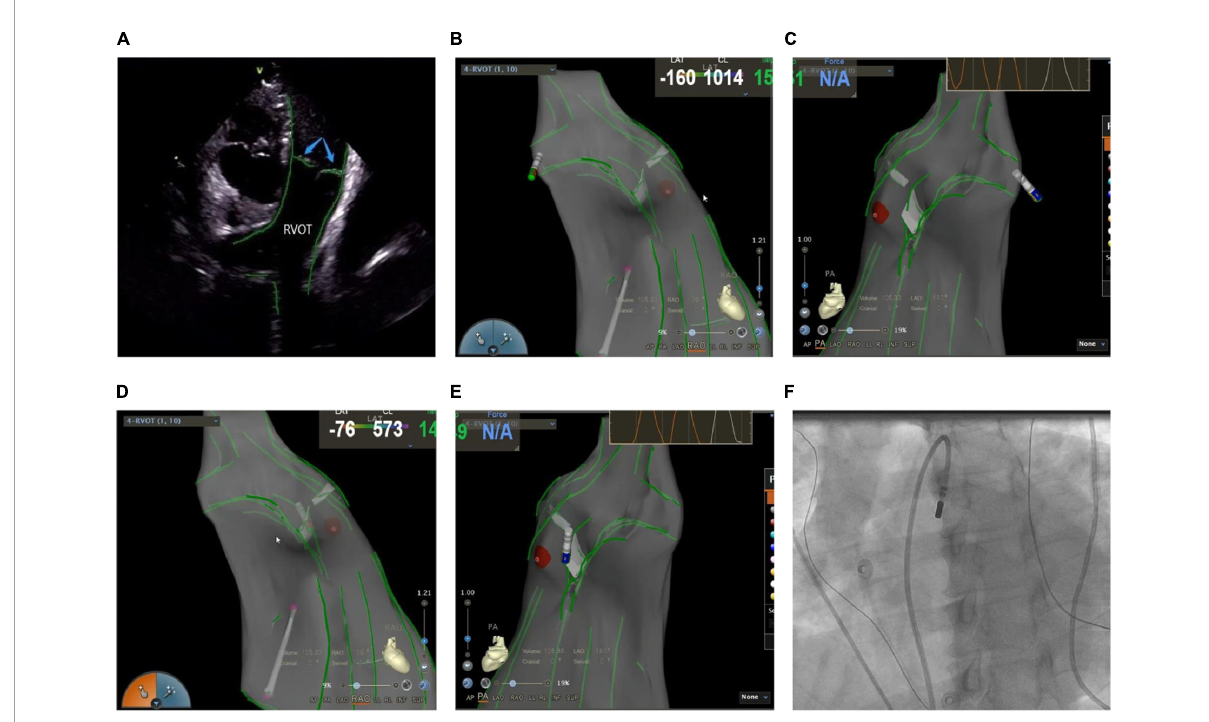
FIGURE5 (A) Anatomic reconstruction of right ventricular outflow tract under ICE. RVOT: right ventricular outflow tract; Blue arrow: pulmonary valve. (B,C) Image of the catheter successfully entering the pulmonary artery under the CARTOSOUND module. (B) Right anterior oblique view; (C) pulmonary artery view. (D,E) Image of the catheter successfully attached to the pulmonary sinus in a reverse U-shape under the CARTOSOUND module. (D) Right anterior oblique view; (E) pulmonary artery view. (F) Successful placement of the catheter above the pulmonary sinus was verified by